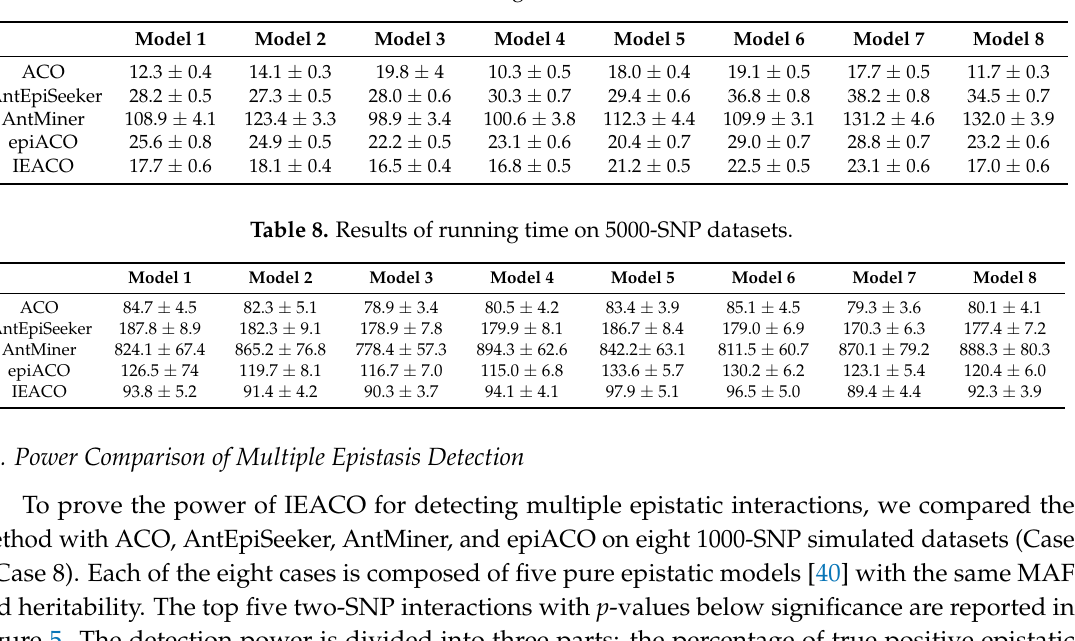
Figure 5. The detection power is divided into three parts: the percentage of true positive epistatic interactions, the percentage of false positive epistatic interactions, and the percentage of